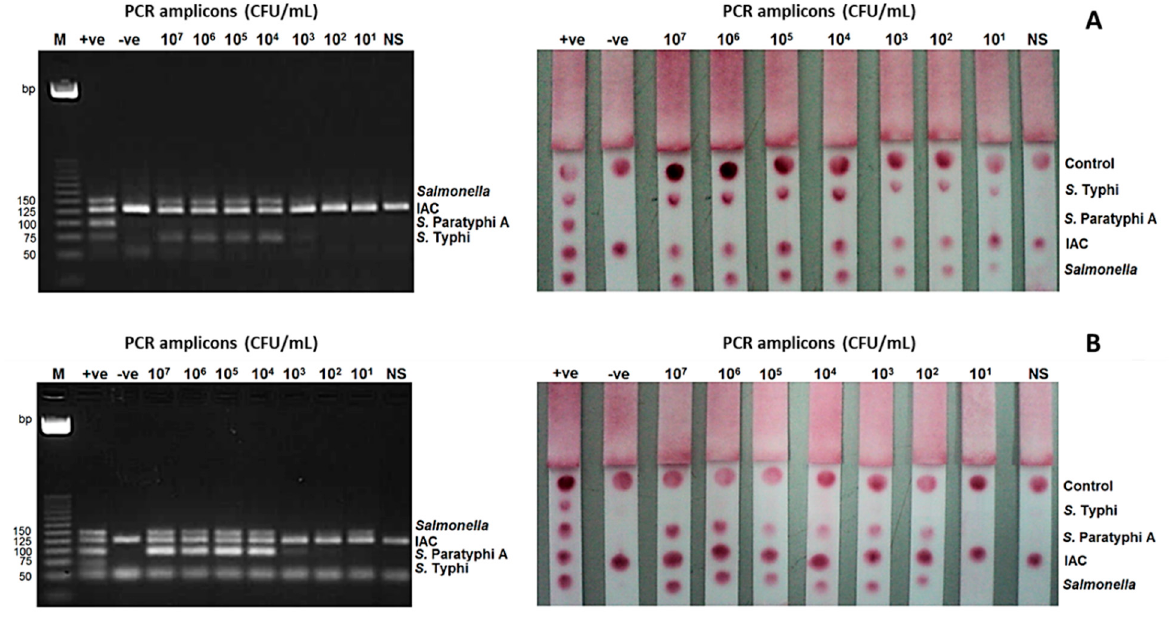
Figure 3. Limit of detection (LoD) of the mPCR-LFB and mPCR-AGE were determined using different concentrations of PCR amplicons ranging from 10 7 to 10 1 CFU/mL. ( A ) LoD using DNA of S. Typhi was 10 4 CFU/mL using mPCR-AGE and 10 1 CFU/mL using mPCR-LFB. ( B ) LoD using DNA of S. Paratyphi A was 10 4 CFU/mL using mPCR-AGE and 10 2 CFU/mL using mPCR-LFB. M= 25 bp markers, +ve= positive control, -ve= negative control.